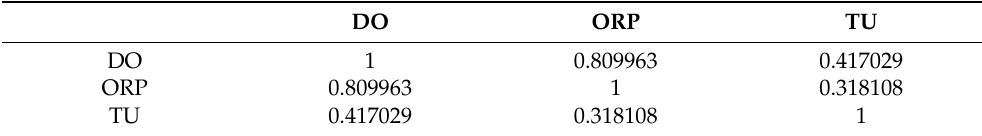
Table 3. Correlation coefficients between auxiliary